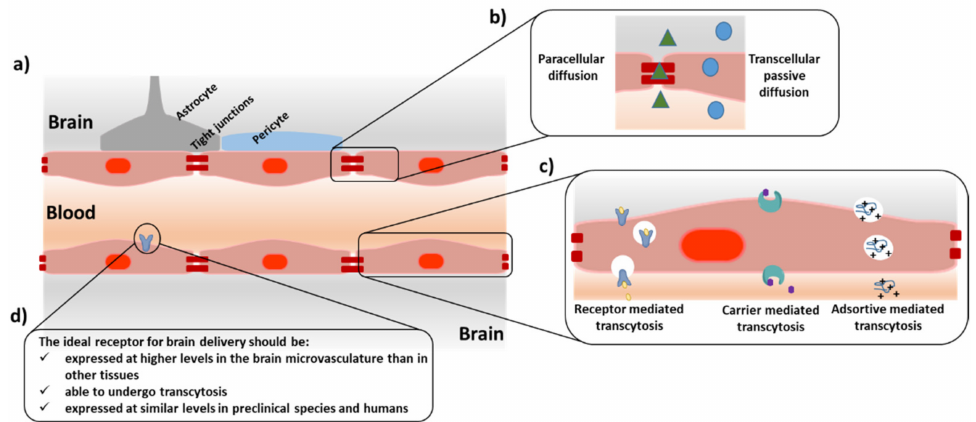
Figure 1. Schematic representation of the blood–brain barrier structure (BBB). ( a ) The blood–brain barrier comprises a monolayer of endothelial cells in intimate contact with astrocytes’ end-feet and pericytes. The endothelial cells are strongly bound by tight junction (TJs) proteins. ( b ) Passive transport mechanisms are divided into paracellular diffusion and transcellular passive diffusion; ( c ) active transport mechanisms include transcytosis mediated by receptors and transporters and adsorptive-mediated; ( d ) minimal requirements of a receptor for targeted brain